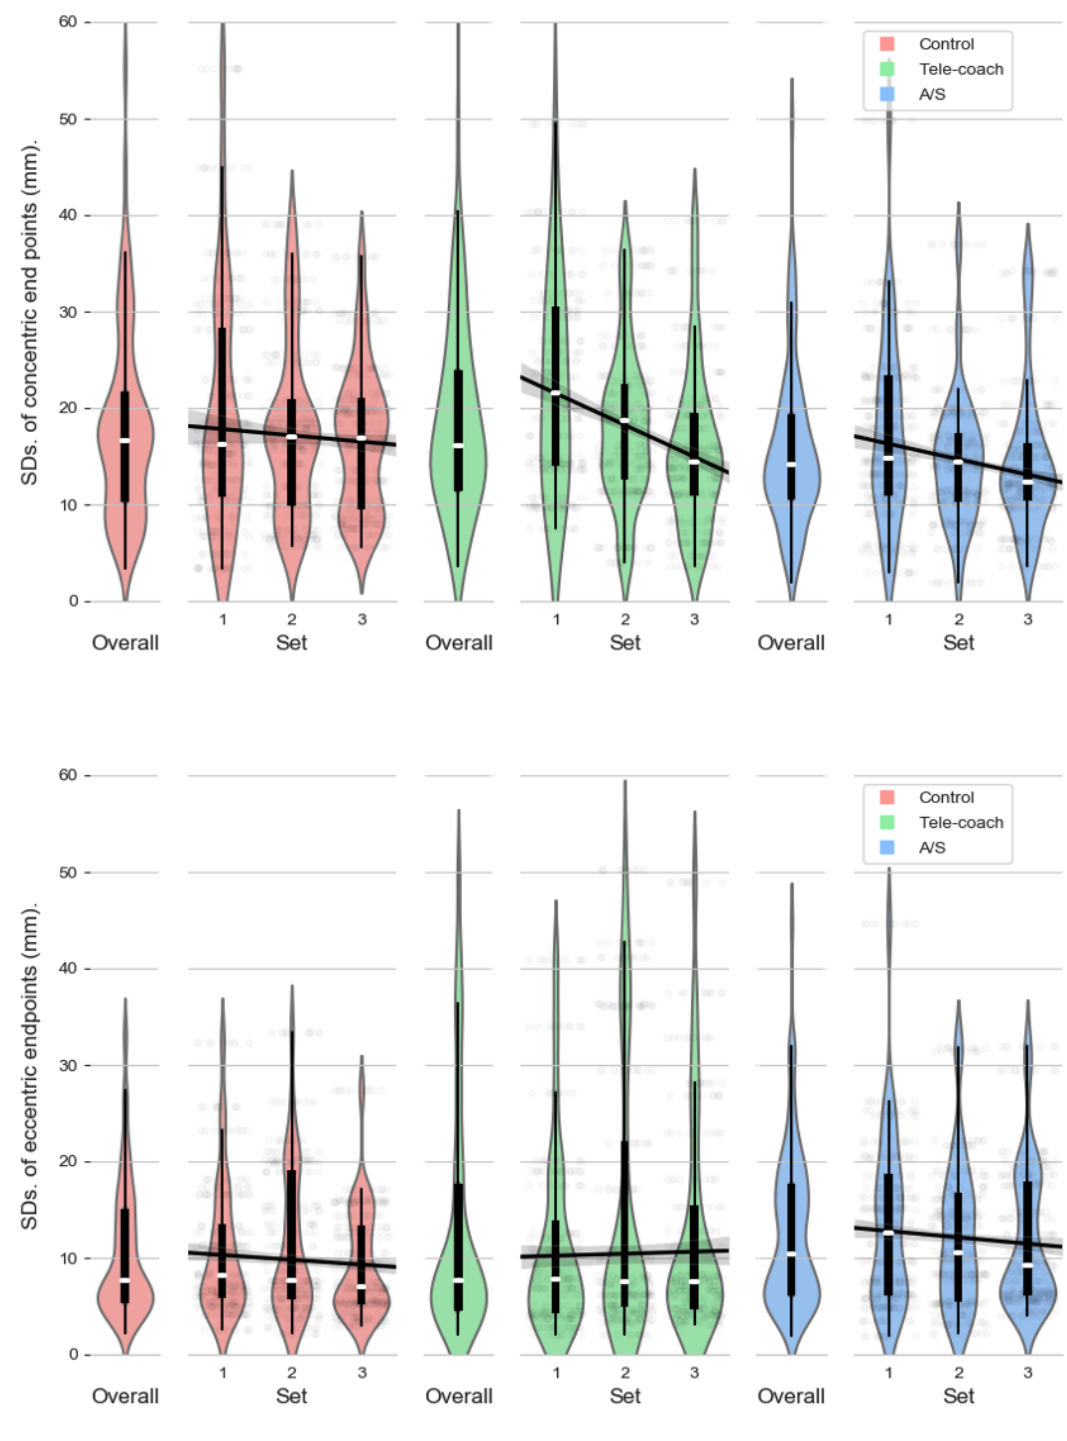
Figure 6. Distributions of the variations (standard deviation) in concentric (top) and eccentric (bottom) contraction endpoints colored by condition and reported per set. A/S: ambient light and